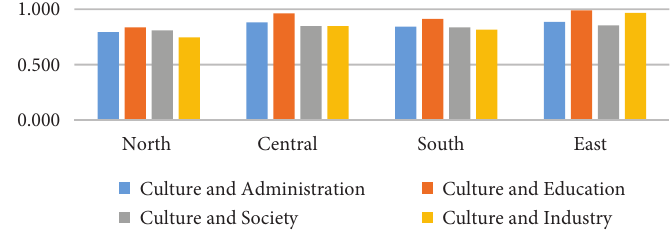
Figure 6. Regional